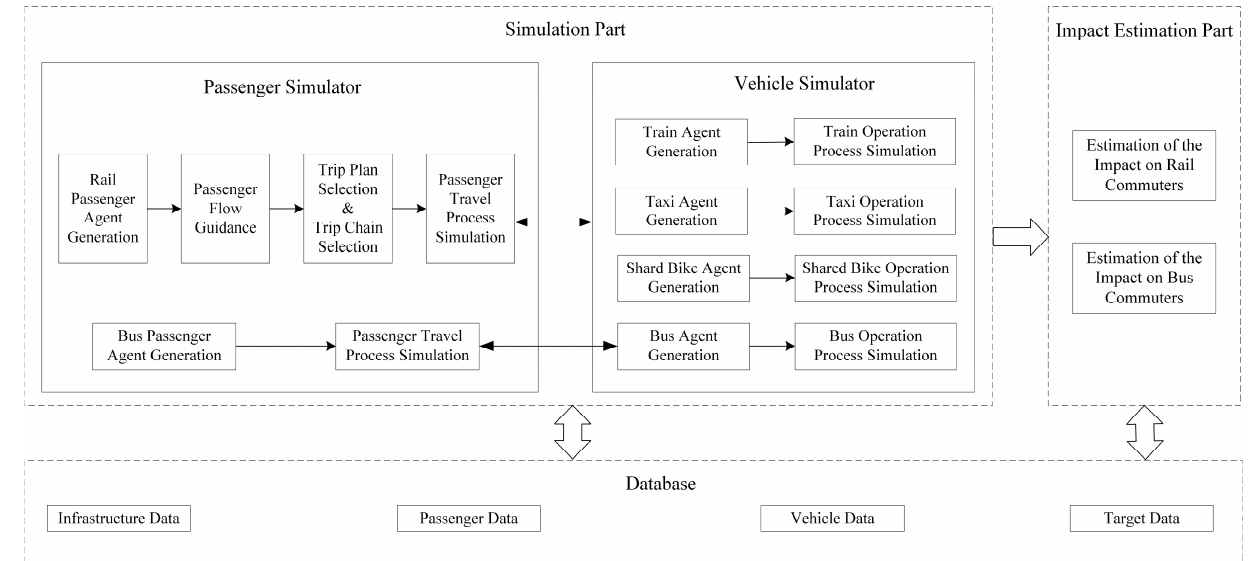
Figure 4. The logical framework of the multi-agent simulation system.